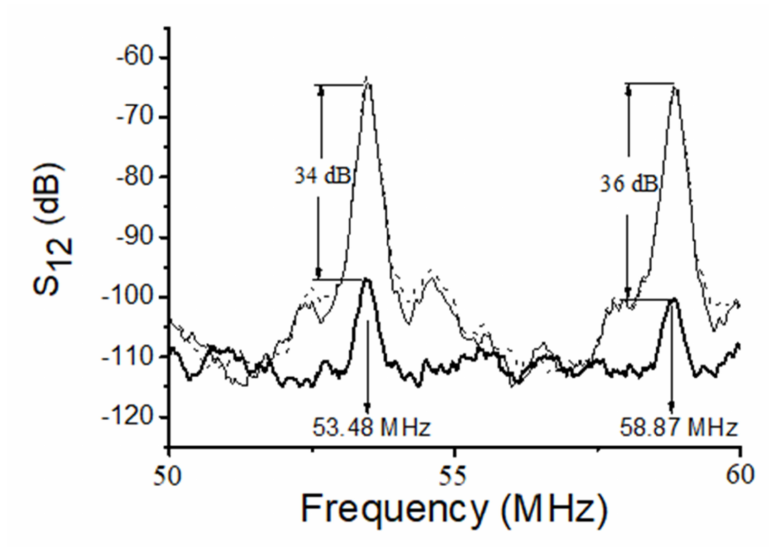
Figure 4. Insertion loss S 12 of the SH-modes with high sensitivity towards viscosity measured at h = 300 µ m, λ = 300 µ m, and h/ λ = 1.0 in ST,X + 90 ◦ -quartz plate with two free faces (thin solid), one free face, one water-loaded face (dashed), and one glycerin-loaded face (thick solid). Liquids are over the propagation path L = 22 mm on the bottom of the plate.